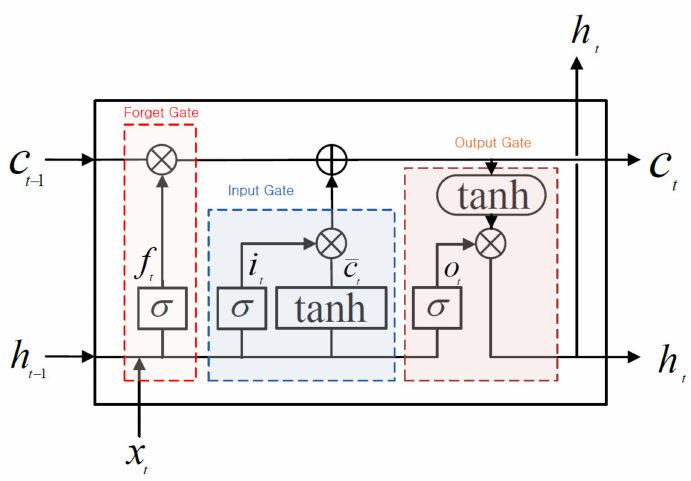
Figure 3. Long Short-Term Memory (LSTM).